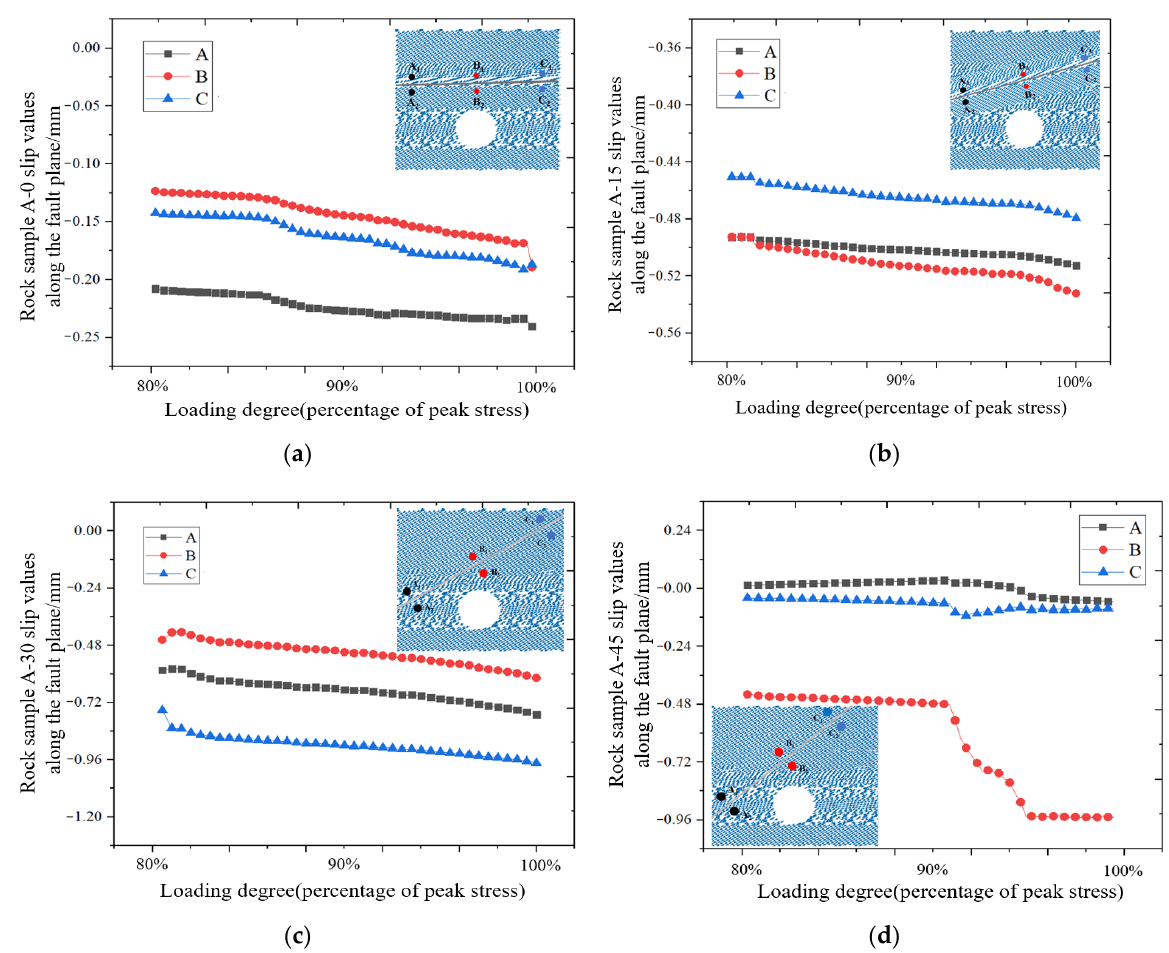
Figure 10. Schematic diagram of the relationship between fracture slip at measurement points and loading degree in group A. ( a ) sample A ‐ 0 slip values; ( b ) sample A ‐ 15 slip values; ( c ) sample A ‐ 30 slip values; ( d ) sample A ‐ 45 slip values.